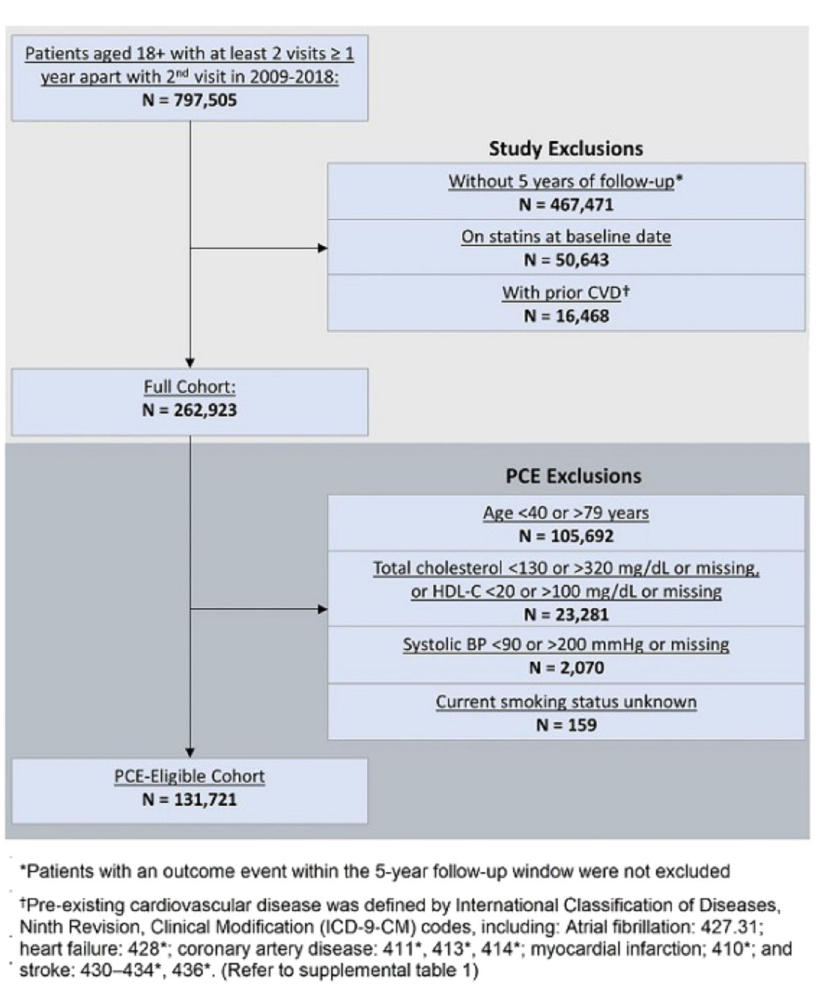
Fig. 1 Consort diagram. N number, ASCVD atherosclerotic cardiovascular disease, CVD cardiovascular disease, PCE pooled cohort equation, HDL-C high-density lipoprotein cholesterol, BP blood pressure. *Patients with an outcome event within the 5-year follow-up window were not excluded. † Pre-existing cardiovascular disease was de fi ned by International Classi fi cation of Diseases, 9th revision, Clinical Modi fi cation (ICD-9- CM) codes, including: atrial fi brillation: 427.31; heart failure: 428*; coronary artery disease: 411*, 413*, 414*; myocardial infarction: 410*; and stroke: 430 – 434*, 436* (refer to Supplementary Table